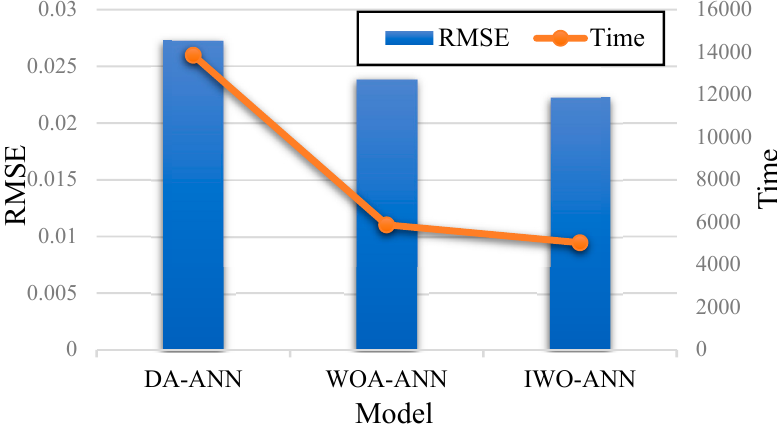
Figure 8. The computation time and the best root mean square error ( RMSE ) of the best-fitted ensembles.